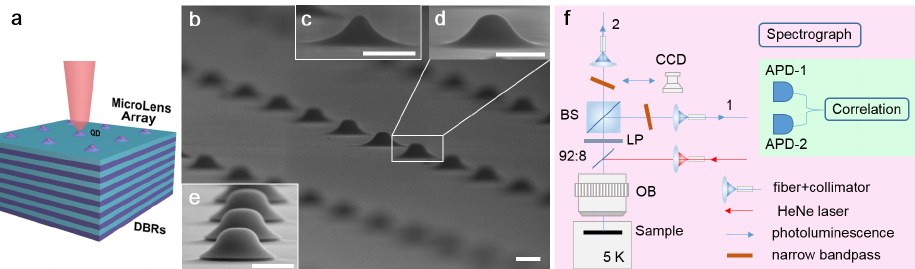
Figure 1. ( a ) Schematic of ML-DBR hybrid structure; ( b – e ) Scanning electron microscope (SEM) images of MLs in different shapes: ( b ) bird-view of ML array; ( c ) peak ; ( d ) gauss ; and ( e ) hat . Scale bars: 1 µ m. ( f ) Confocal and HBT setups for µ PL spectroscopy and photon correlation